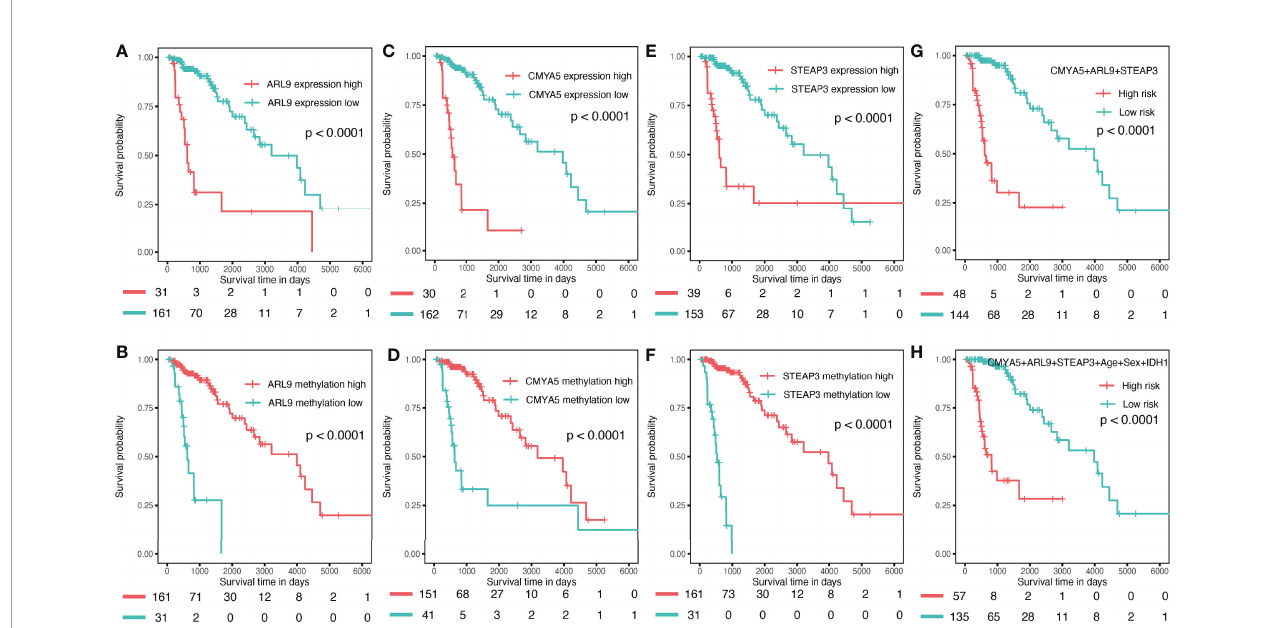
FIGURE 8 | Validation in the internal validation set. (A – F) K – M OS curves for 3-gene expression and methylation in the internal validation set. (G) combination of three genes. (H) of the